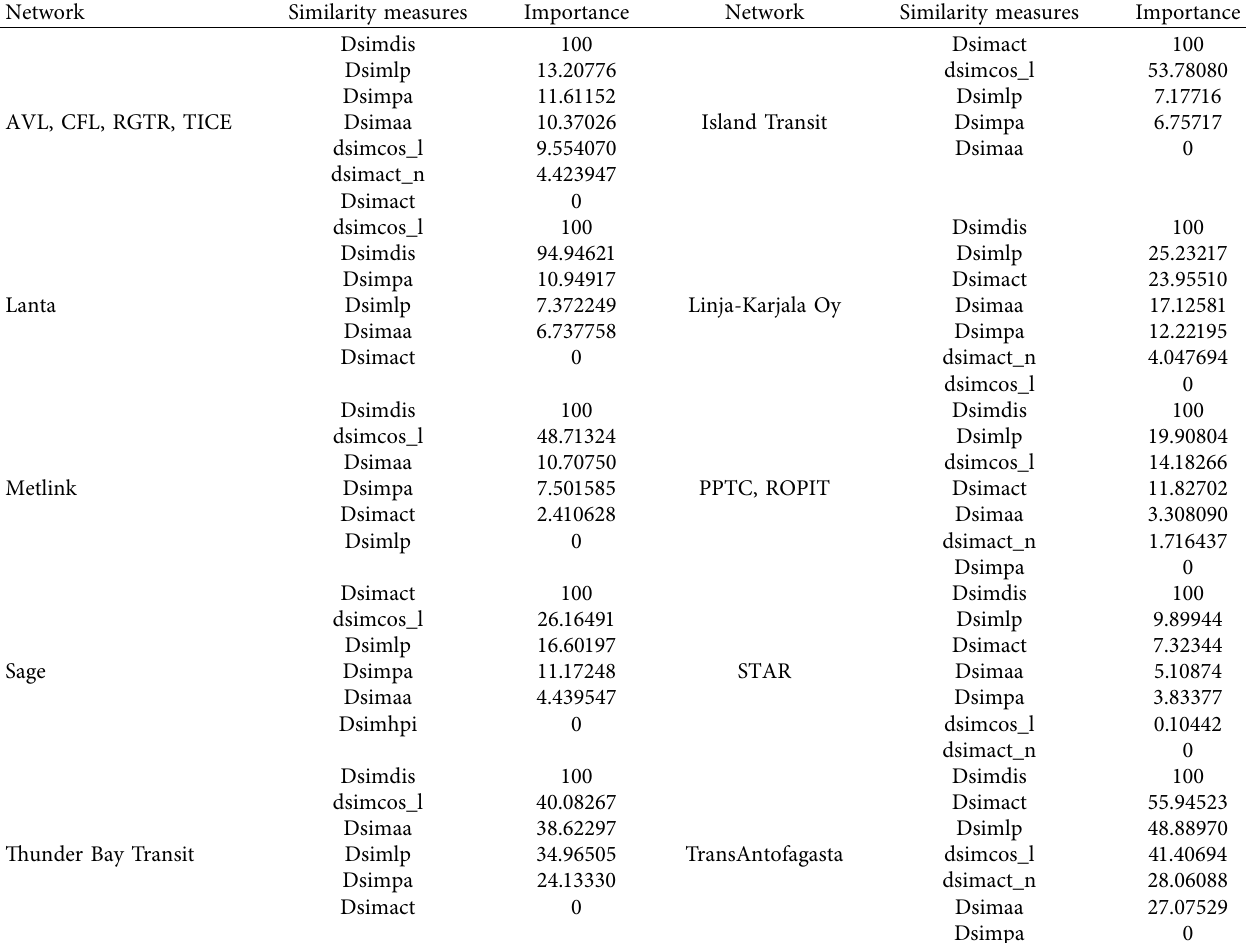
Table 4: Importance of